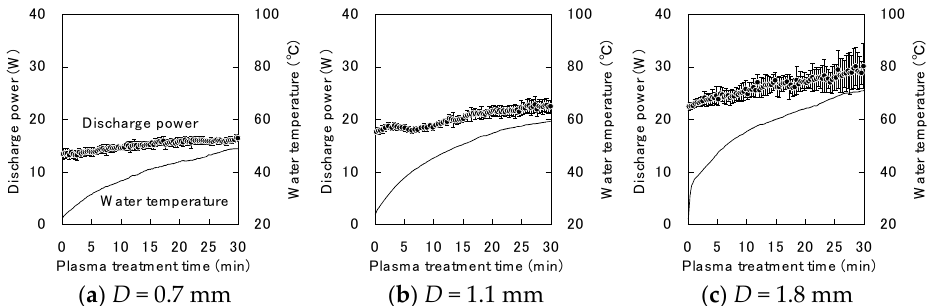
Figure A2. Changes in the discharge power and water temperature for various electrode distances, D , with circulation cooling by room-temperature water.